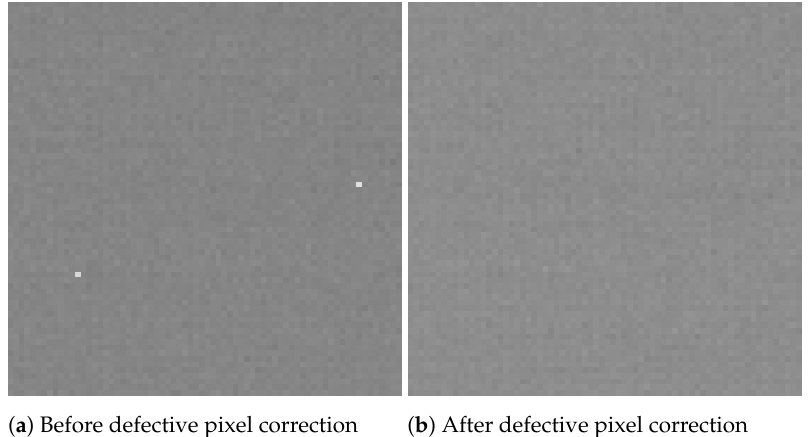
Figure 12. A cutout of an image captured from the camera looking at a uniform blackbody source. The image contains two defective pixels before correction.